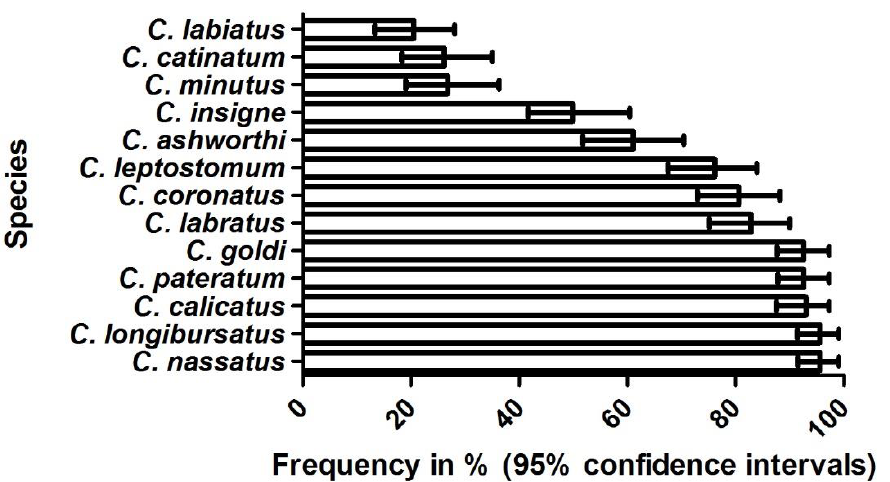
Figure 1. Frequency of 13 cyathostomin species detected by Reverse Line Blot analysis of DNA samples extracted from the cultured larvae obtained from horses which did not receive anthelmintic treatment during the prior eight weeks and showed strongyle eggs in their feces ( n = 195). Bars indicate the occurrence in %, and 95% confidence intervals are provided as Ⱶ .